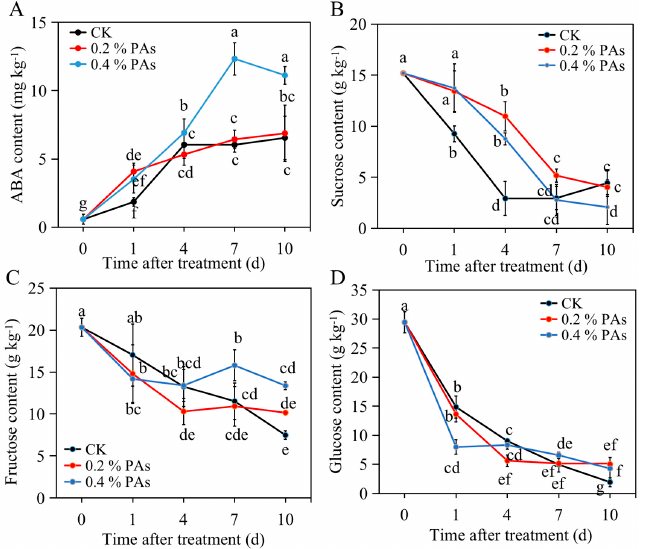
Figure 3. Effects of PA treatment on ( A ) ABA content, ( B ) sucrose, ( C ) fructose, ( D ) glucose content. All data are presented as mean values ± standard deviation. Mean values were obtained from three independent biological replicates. The lowercase letters indicate significant difference based on LSD multiple test at p ≤ 0.05 level.